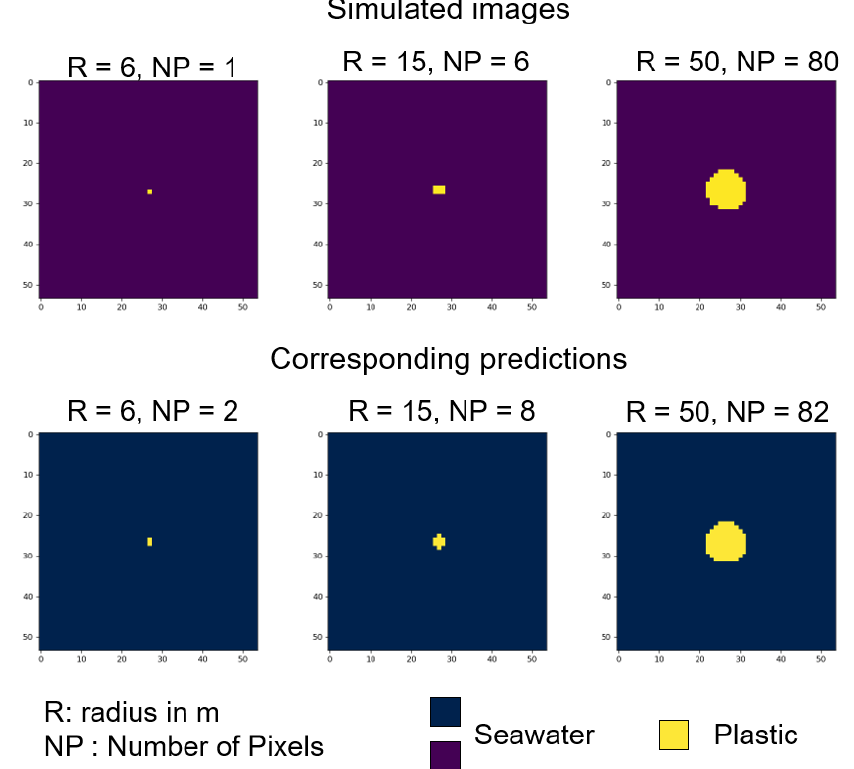
Figure 9. Comparison between the masks of simulated images ( top ) and the corresponding predic- tions for each image ( bottom ) for inaccurate